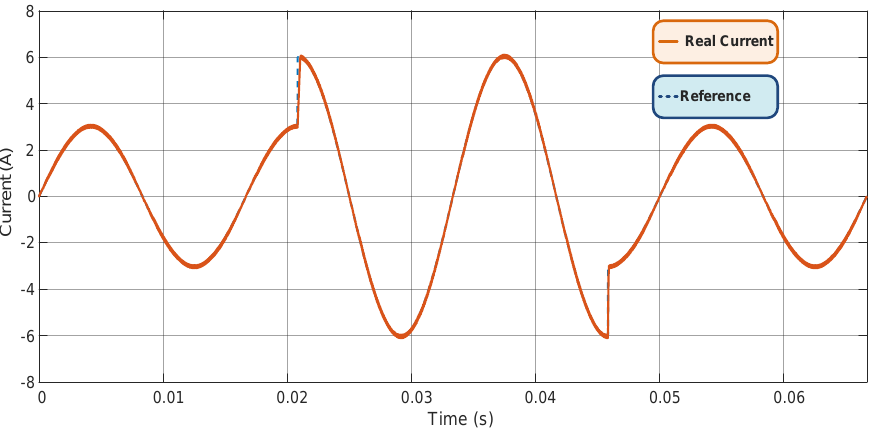
Figure 7. Comparison between currents 𝑖 1 ∗ and 𝑖 1 .